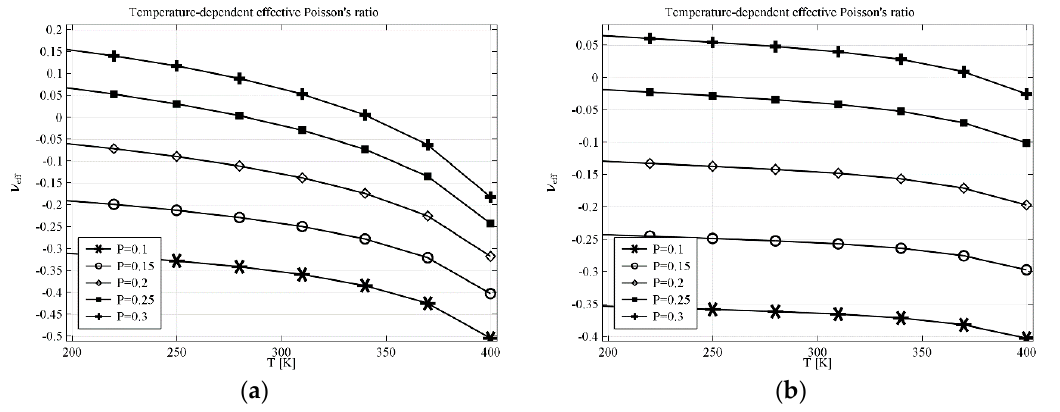
Figure 3. Effective Poisson’s ratio for AT (anti-tetrachiral) geometry with linking elements in the case of ( a ) computational linking material; ( b ) real linking material. Geometry parameters: L = 1, R = 0.33, r = 0.25, P —a variable